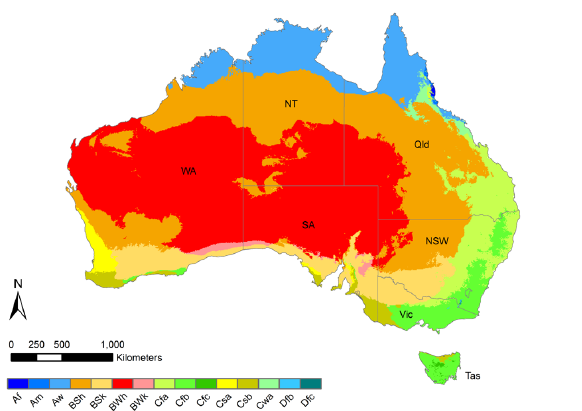
Fig. 1. Historical baseline K¨oppen-Geiger climate types for the pe- riod